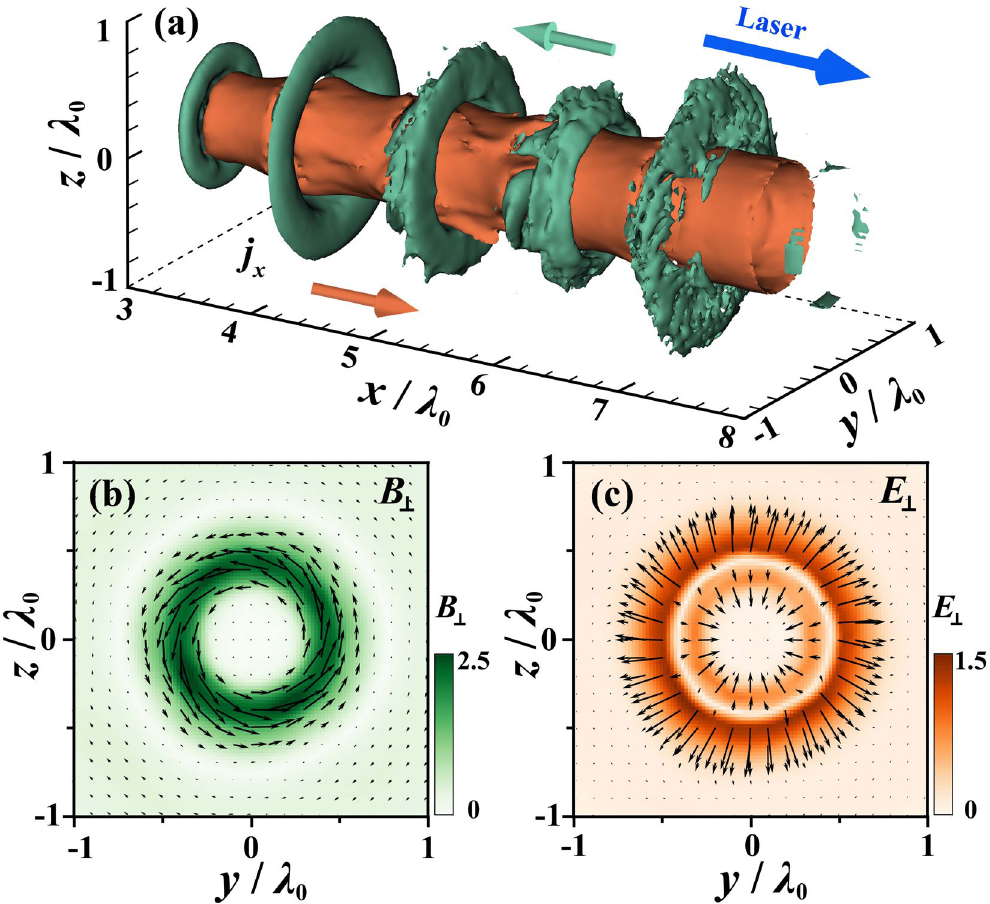
Figure 5. 3D isosurface of longitudinal current densities ( j x = − 1.1 MA/m 2 , green; = . ′ j 1 1 t = 10 T 0 ( a ). Averaged quasi-static magnetic field B ⊥ ( b ) and electric field E ⊥ ( c ). The electric and magnetic fields are respectively normalized by E 0 = m e c ω 0 / q e and B 0 = m e ω 0 / q e